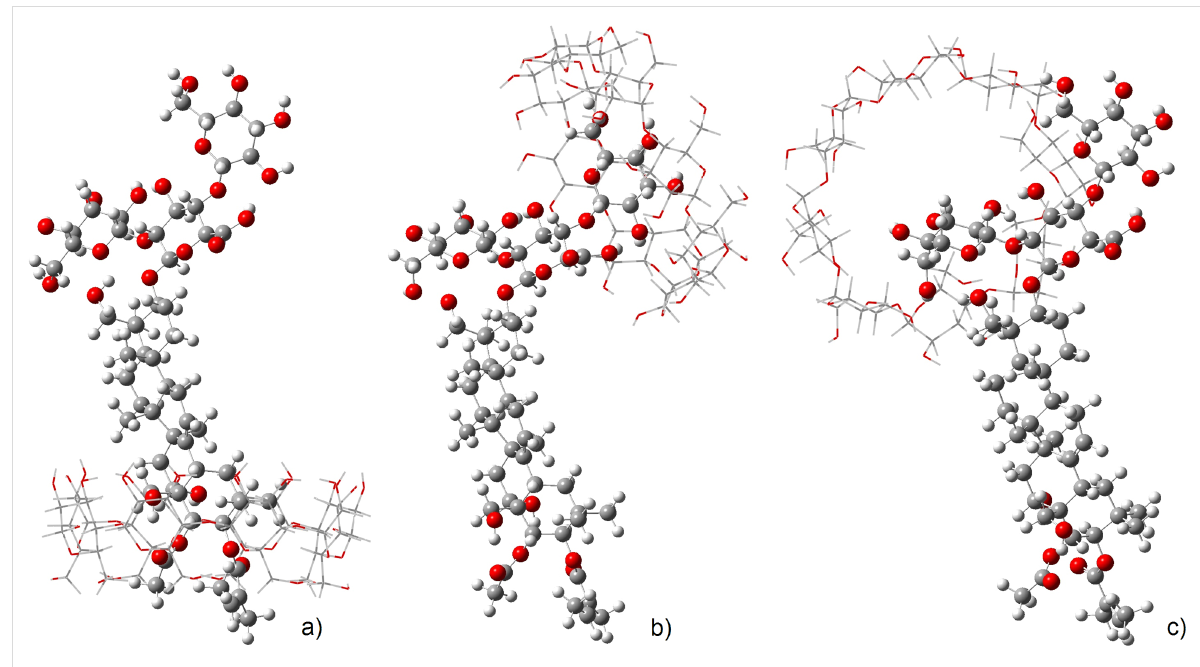
Figure 7: Optimised geometries for three different hypothetical structures of γ -CD·aescin, deemed complex γ 1 (a) complex γ 2 (b) and complex γ 3 (c). The structures have the same orientation to facilitate viewing.